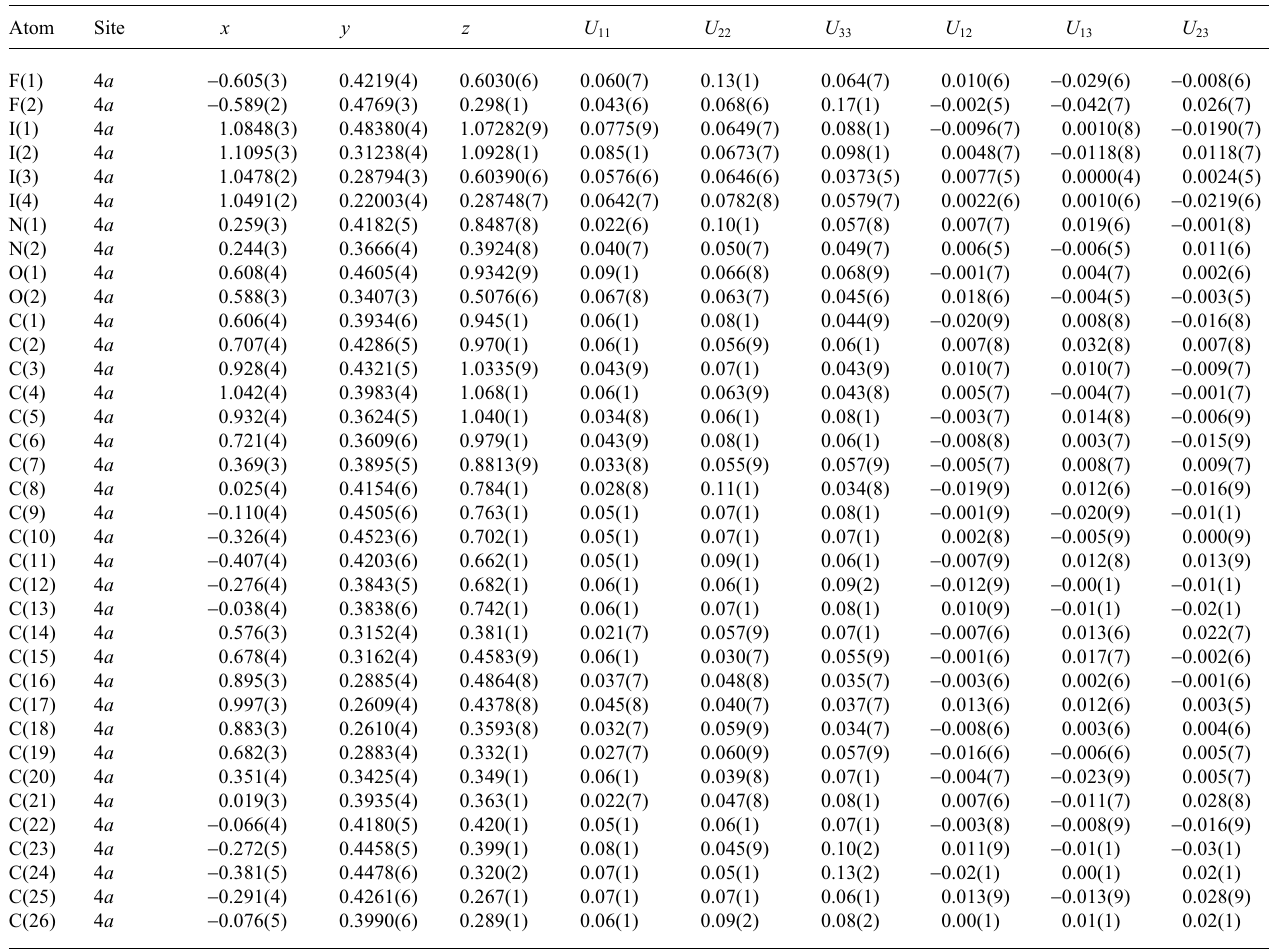
Table 3. Atomic coordinates and displacement parameters (in Å 2 )